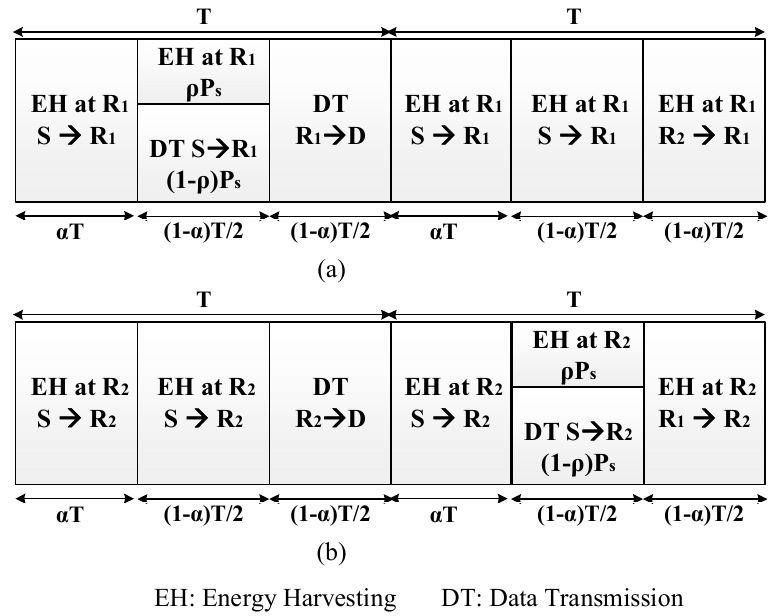
Figure 2. The information transmission and energy harvesting process. ( a ) R1-DT and R2-EH; ( b ) R2-DT and R1-EH.